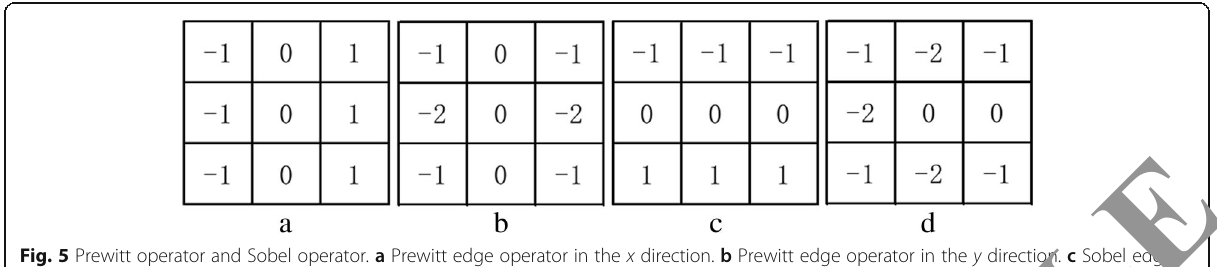
Fig. 5 Prewitt operator and Sobel operator. a Prewitt edge operator in the x direction. b Prewitt edge operator in the y direction. c Sobel edge operator in the x direction. d Sobel edge operator in the y direction